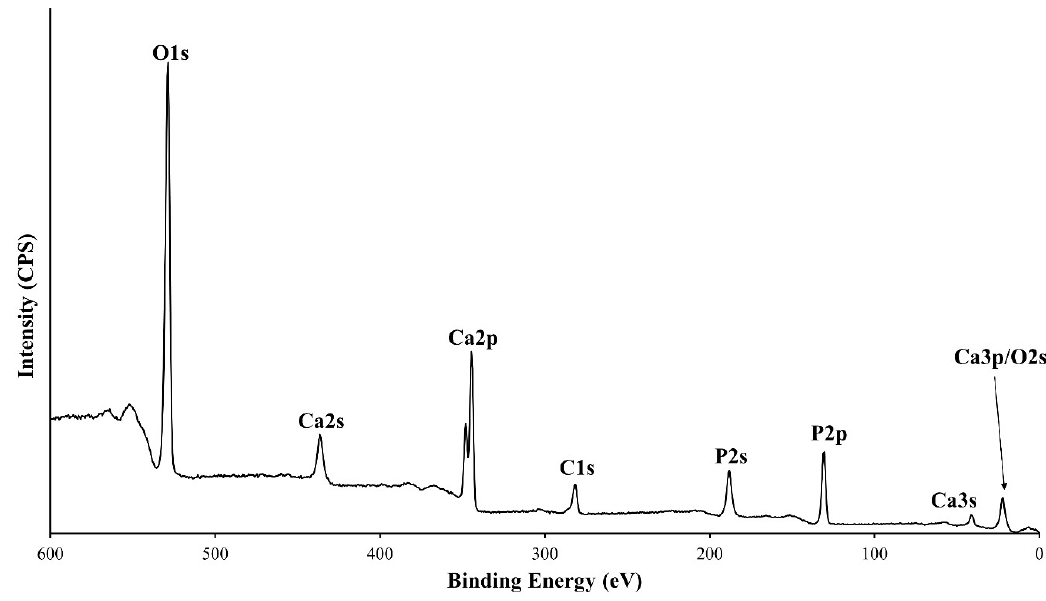
Figure 7. XPS survey scan (0–600 eV) for HA600.